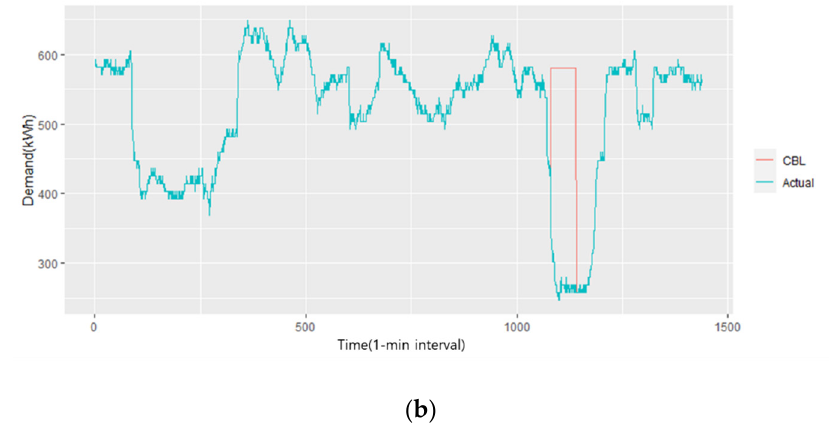
Figure 6. Industrial DR performance profiles for ( a ) cement plant #1 and ( b ) cement plant #2.